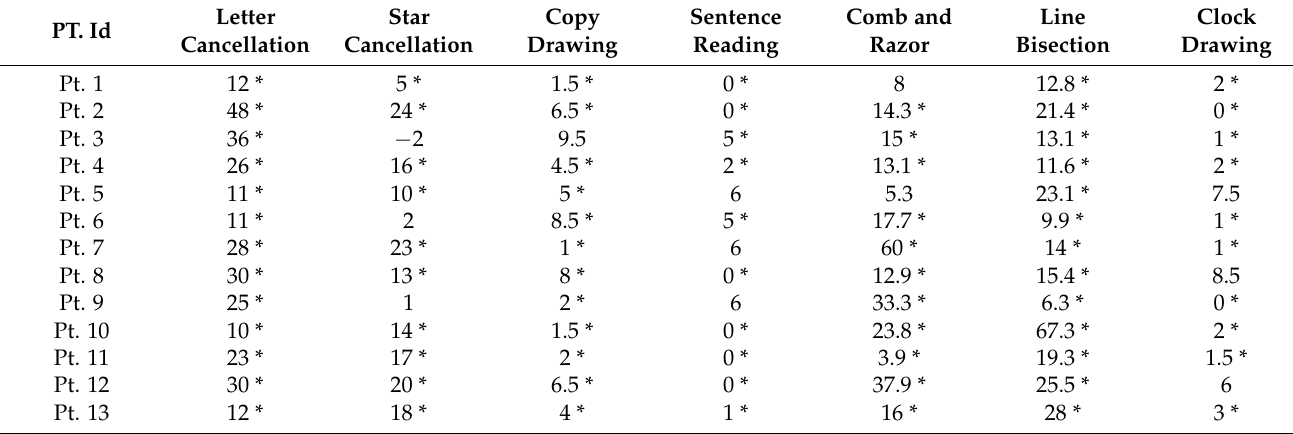
Table 2. Neuropsychological assessment of unilateral spatial neglect at first examination (T1). PT.